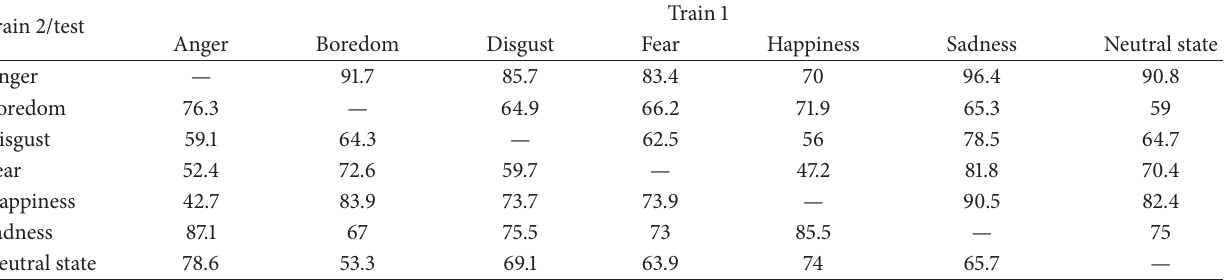
Table 6: Gaussian mixture model classification accuracy for different combinations of emotions